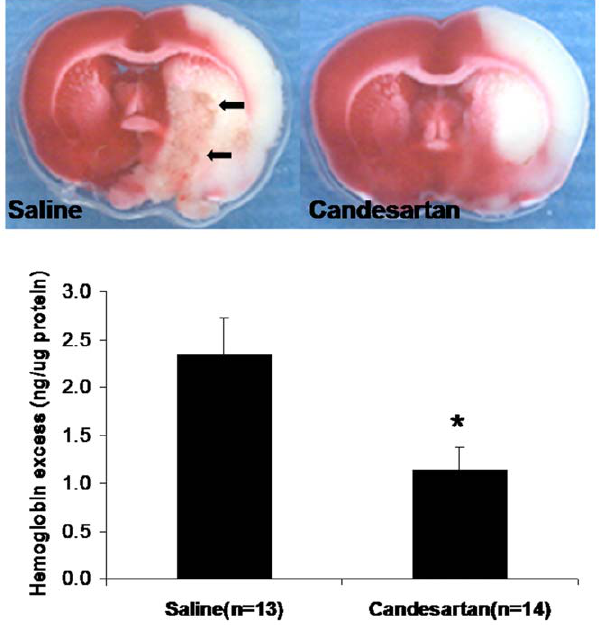
Figure 2. Hemorrhage. ELISA was performed on the brain tissue form candesartan and saline treatment animals 24 hours after stroke onset. Treatment with candesartan significantly decreased hemoglobin excess (*P , 0.05) in the ischemic brain, as compared with the saline-treated animals. Arrows indicate hemorrhagic transformation of the ischemic lesion in a representative animal.